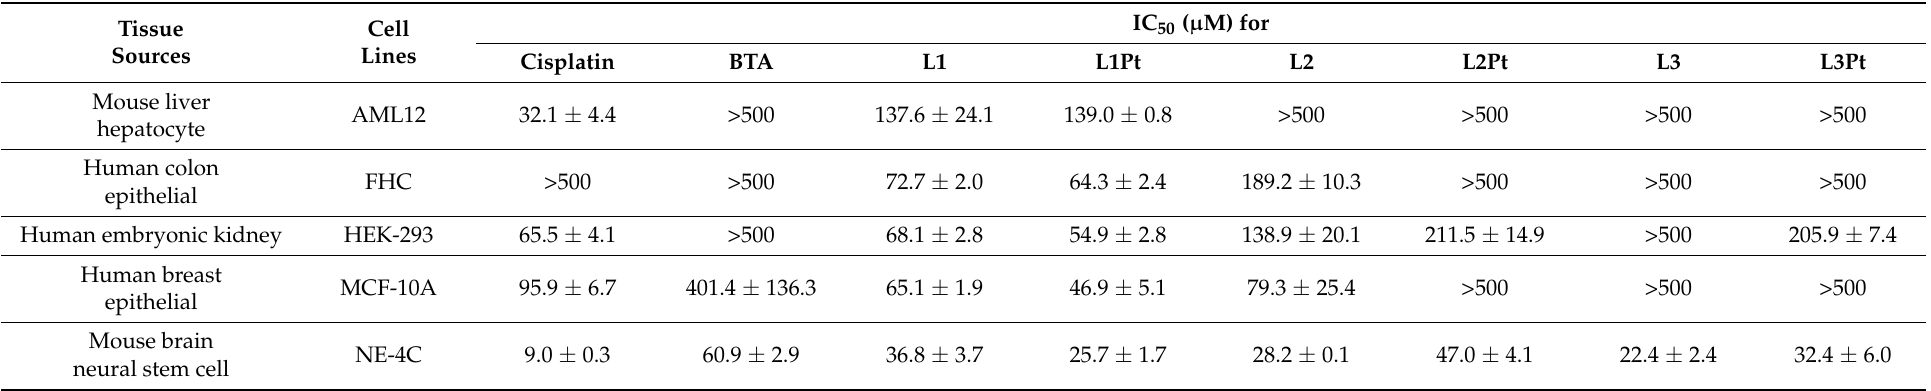
Table 2. Half inhibition concentration (IC 50 ) of synthesized compounds in normal cells. Various normal cells treated with different concentrations of compounds were assayed for cell viability by the CCK-8 method at 24 h and IC 50 values were calculated using the GraphPad Prism 5 software. IC 50 values for compound against each cell line are means of three independent experiments ( n = 3, mean ± SEM). Cisplatin and BTA, which are the backbones of the compounds, were compared as positive